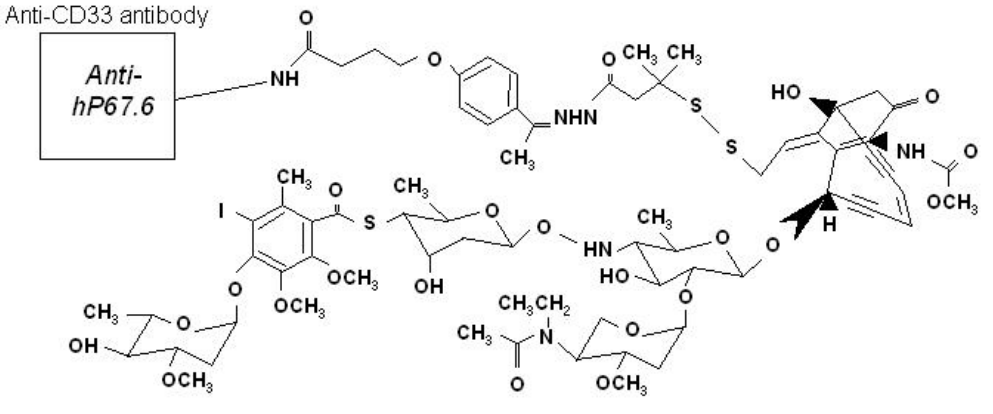
FIGURE 3. Gemtuzumab ozogamicin (Mylotarg ® ). NAc- γ -calicheamicin is linked to the humanized form (IgG 4 ) of anti- CD33 monoclonal antibody,